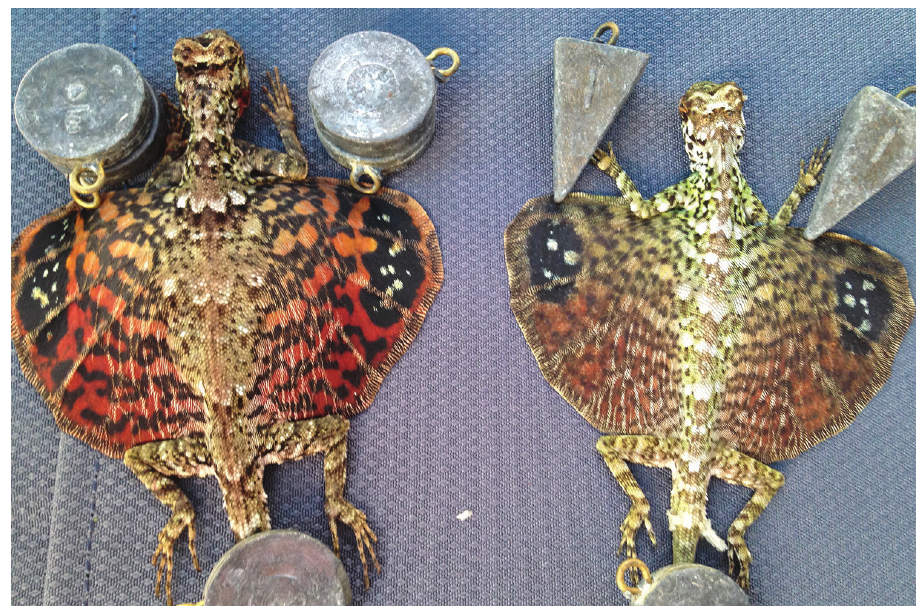
Figure 42. Draco ornatus has been recorded only from Dinagat Island and Agusan del Norte Province. Pho- tos: RMB ( A dorsal; B ventral, from the Municipality of Burauen, Leyte Island; specimens deposited at